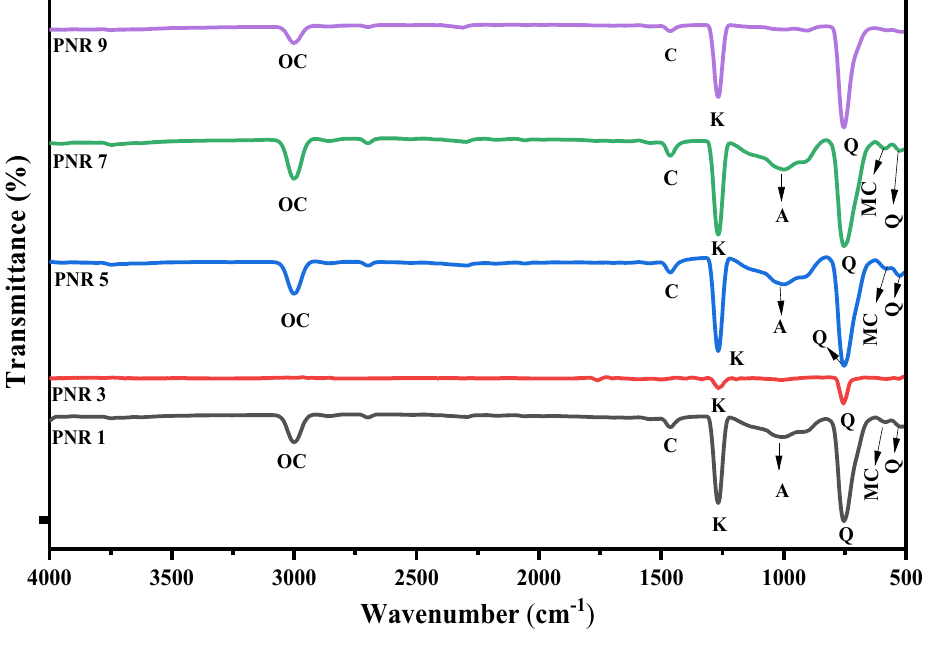
Figure 2. FT-IR spectrum of river sand samples